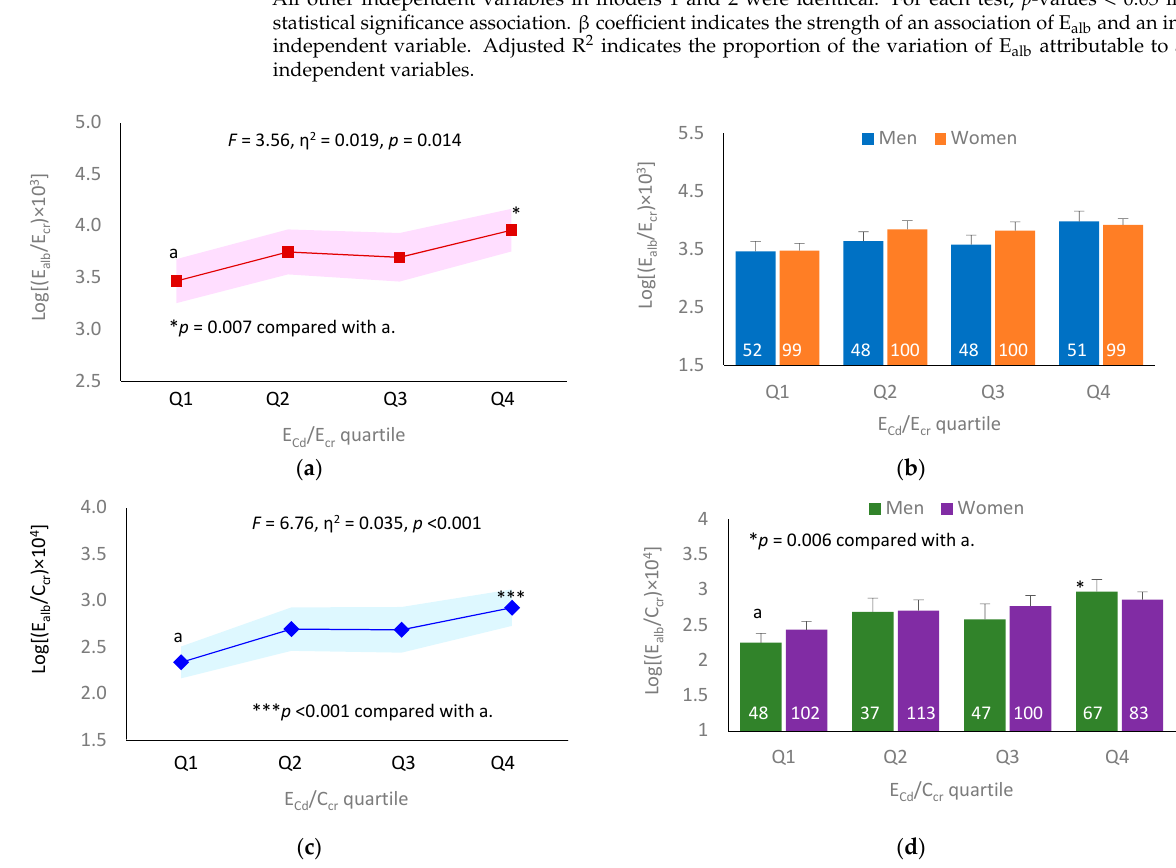
Figure 1. Comparing albumin excretion levels across cadmium excretion quartiles. ( a ) Mean E alb /E cr values with variances across E Cd /E cr quartiles 1 − 4; ( b ) mean E alb /E cr values in men and women in E Cd /E cr quartiles 1 − 4; ( c ) mean E alb /C cr values with variances across E Cd /C cr quartiles 1 − 4; ( d ) mean E alb /C cr in men and women in E Cd /C cr quartiles 1 − 4. Mean values were obtained using univariate analysis with adjustment for